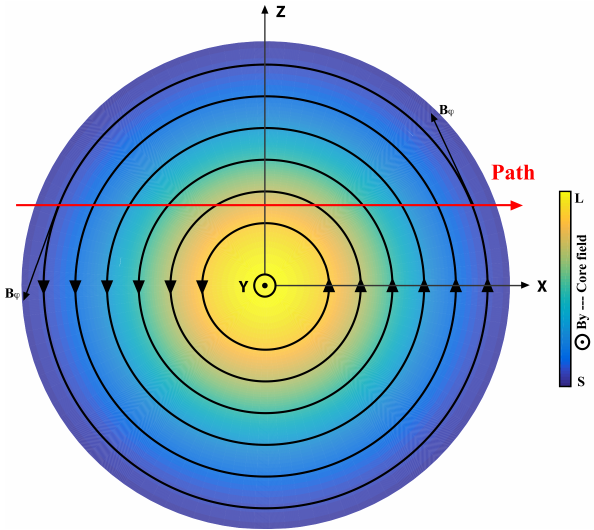
Figure 1. Sketched diagram of the cylindrical flux rope. The flux rope has a right-handed structure. The black circled lines are the magnetic field lines. The red arrow is the projection of spacecraft path. The rectangular coordinate is used in our analyses. Y is the axis orientation of the flux rope, and the X – Z plane is the cross section perpendicular to the axis orientation. The core field is out of plane, and the color represents the relative strength of core field (yellow: large, blue: